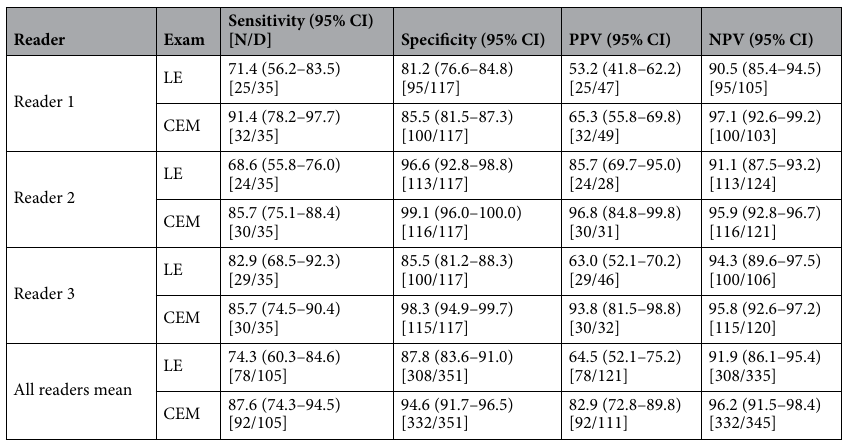
Table 3. Diagnostic accuracy in percentages of LE and CEM exams per individual reader and for all readers combined. The numbers used to calculate the percentages are presented in brackets. CI Confidence interval,